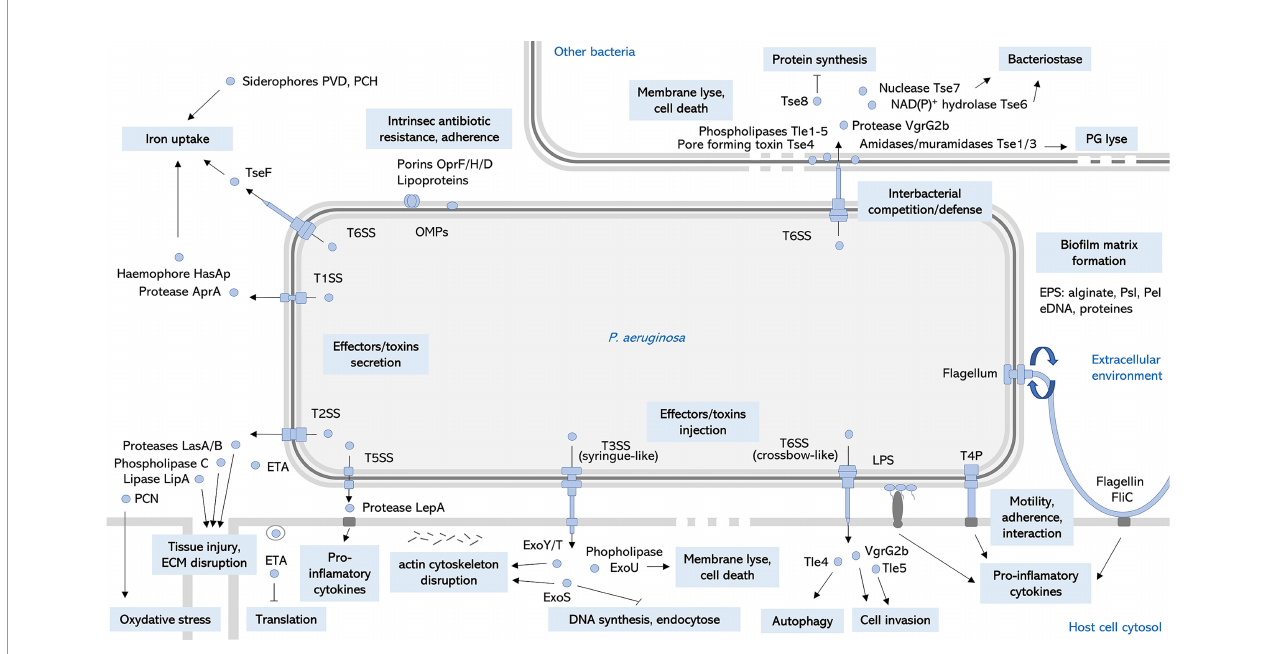
FIGURE 2 | Key virulence factors of P. aeruginosa. S chematic representation of cell-associated and extracellular relevant virulence factors and their main roles on P. aeruginosa pathogenesis. OMPs, outer membrane proteins; LPS, lipopolysaccharide; ROS, reactive oxygen species; EPS, exopolysaccharides; eDNA, extracellular desoxyribonucleic acid; T4P, type 4 pili; TnSS, type n secretion system; ETA, exotoxin A; PVD, pyoverdine; PCH, pyochelin; PCN, pyocyanin; PG, peptidoglycan; ECM, extracellular matrix (Alhazmi, 2015; Sana et al., 2016; Berni et al., 2019; Jurado-Mart ı ́ n et al., 2021; Nolan et al.,